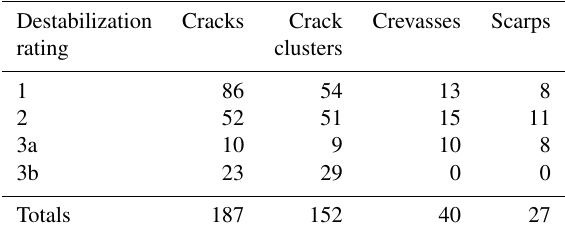
Table 4. Number of rock glaciers per destabilization rating showing a specific surface disturbance. Destabilization Cracks Crack Crevasses Scarps